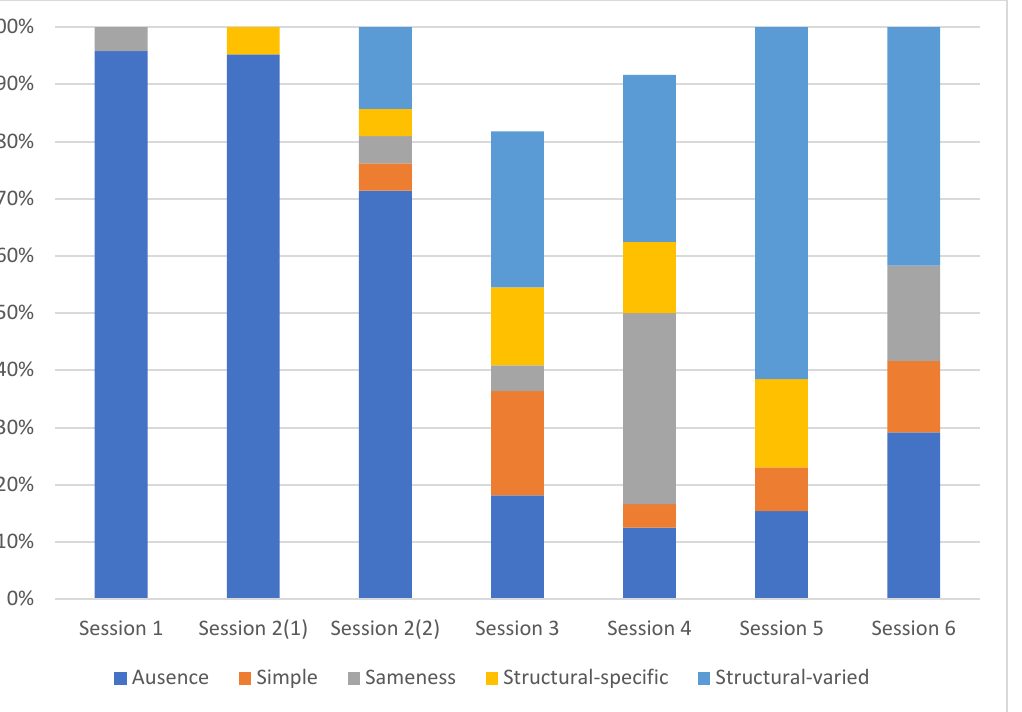
Figure 1. Presence of each profile by session, percentage.